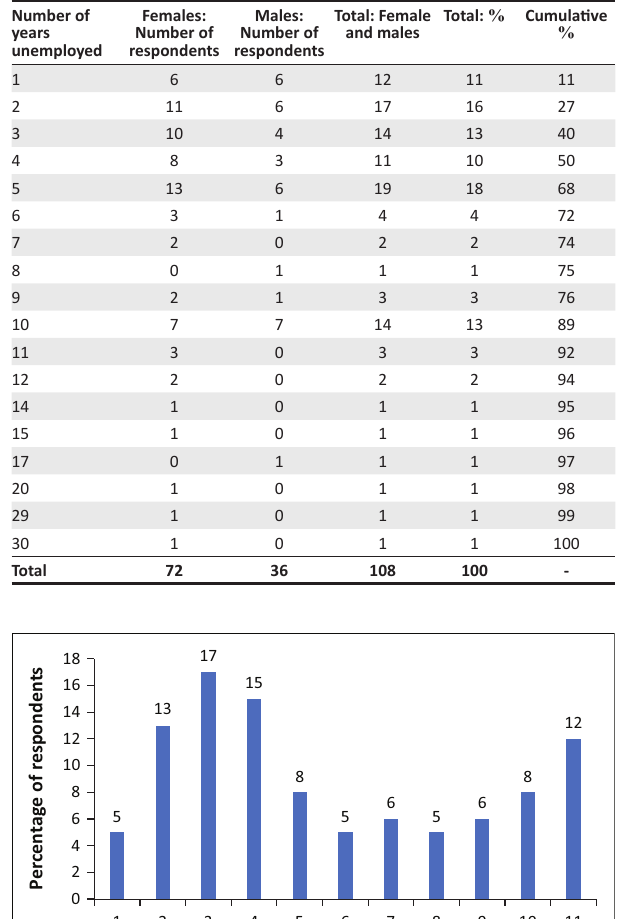
TABLE 1: Respondents’ duration of unemployment prior to joining the community work programme. Number of years